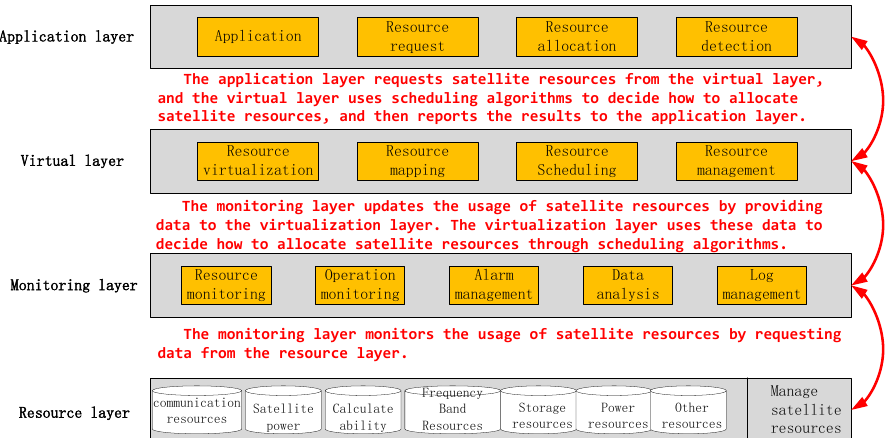
Figure 3. Hierarchical structure